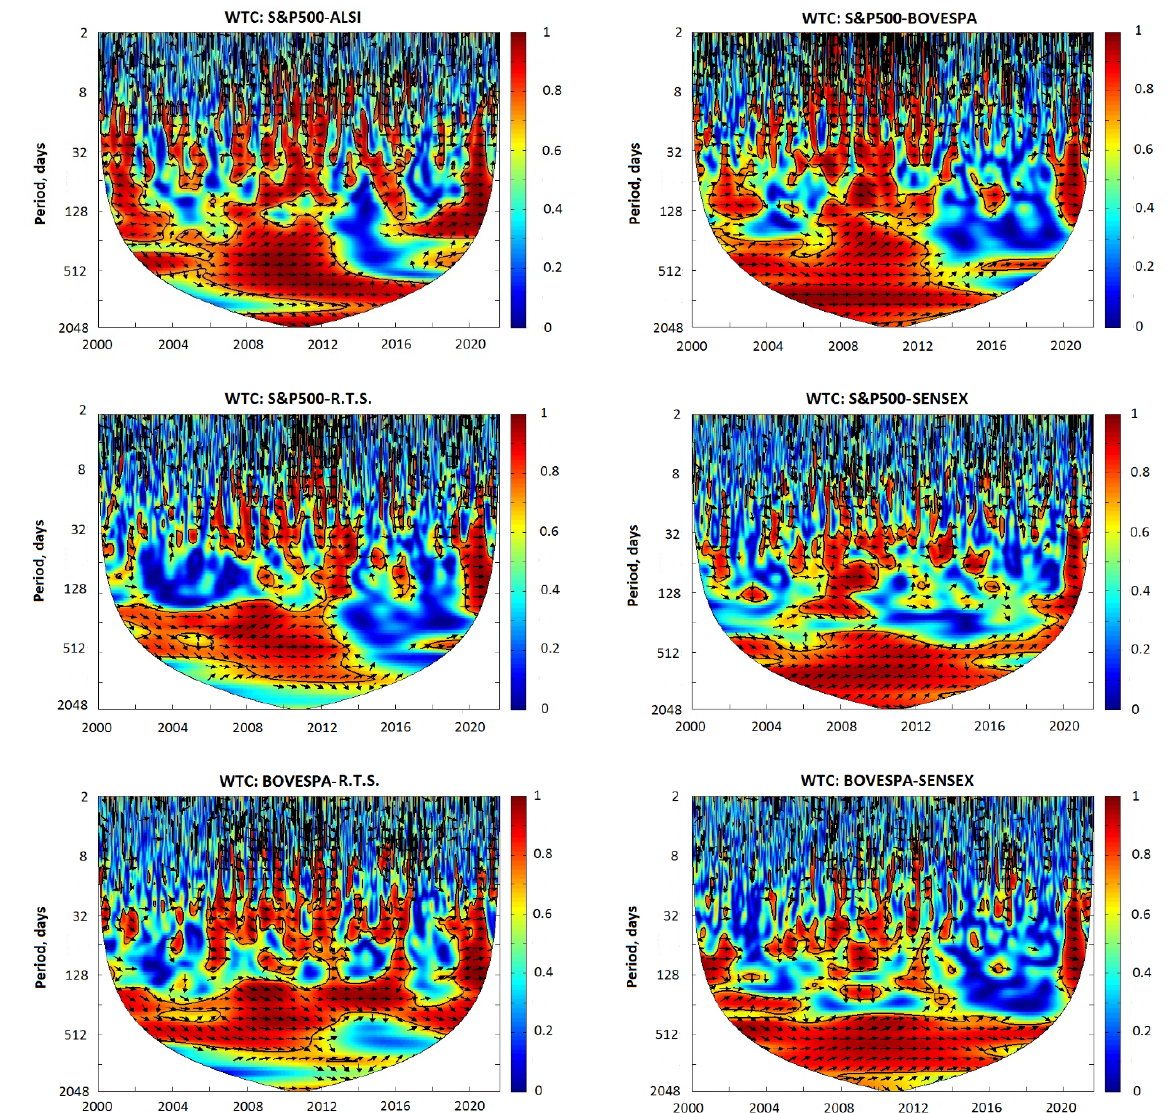
higher correlation (red), as shown in the colour bar. The thick black contour indicates a 5% signifi- cance level against red noise. The relative phase relationship is shown as pointing arrows. Down: the first series leading the second series by 90°; up: the second series leading the first series by 90°; right: in-phase; left: antiphase.